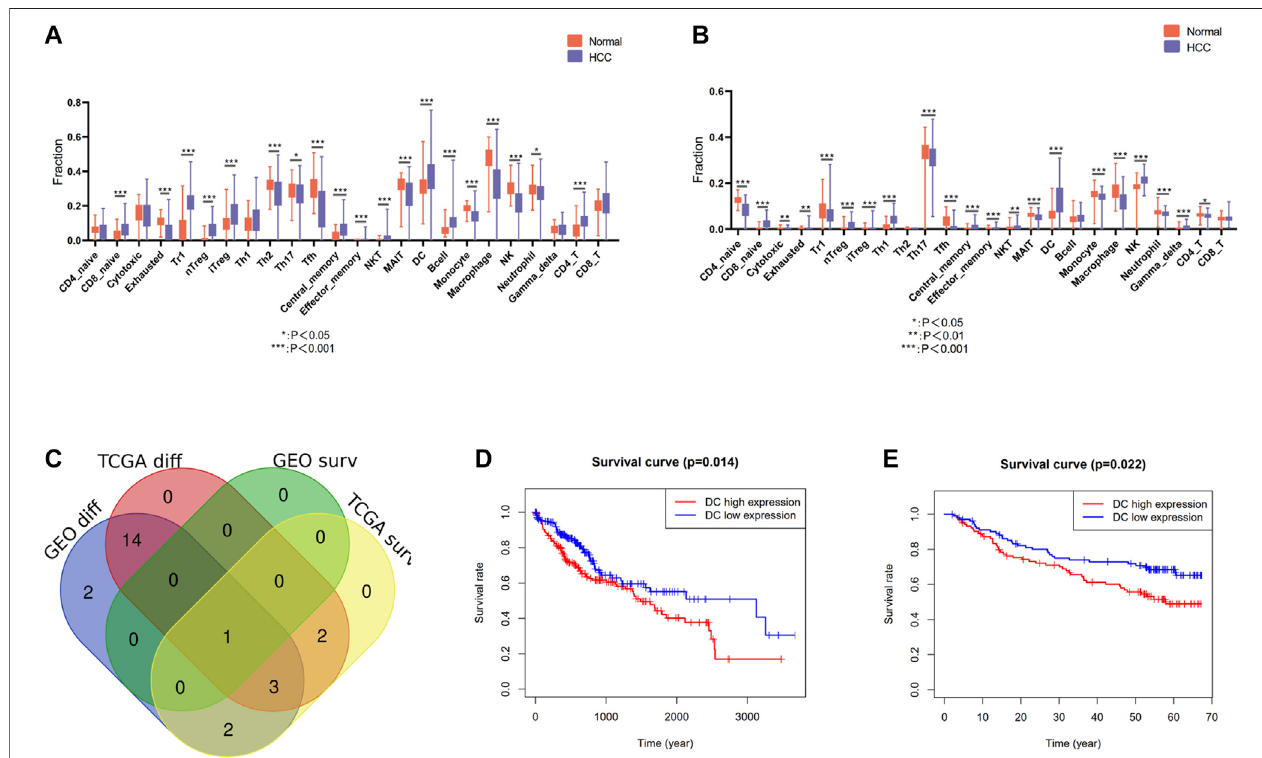
FIGURE 2 | Identi fi cationofdifferentiallyin fi ltrated andprognosticimmunecells. (A) Differentiallyin fi ltrated immunecellsbetweenHCCtissuesandnontumortissuesin the TCGA cohort. (B) Differentially in fi ltrated immune cells between HCC tissues and nontumor tissues in the GEO cohort. (C) Venn diagram of differentially in fi ltrated and prognostic immune cells in TCGA cohort and GEO cohort. (D) Kaplan – Meier analysis of DCs in the TCGA cohort (E) Kaplan – Meier analysis of DCs in the GEO cohort.